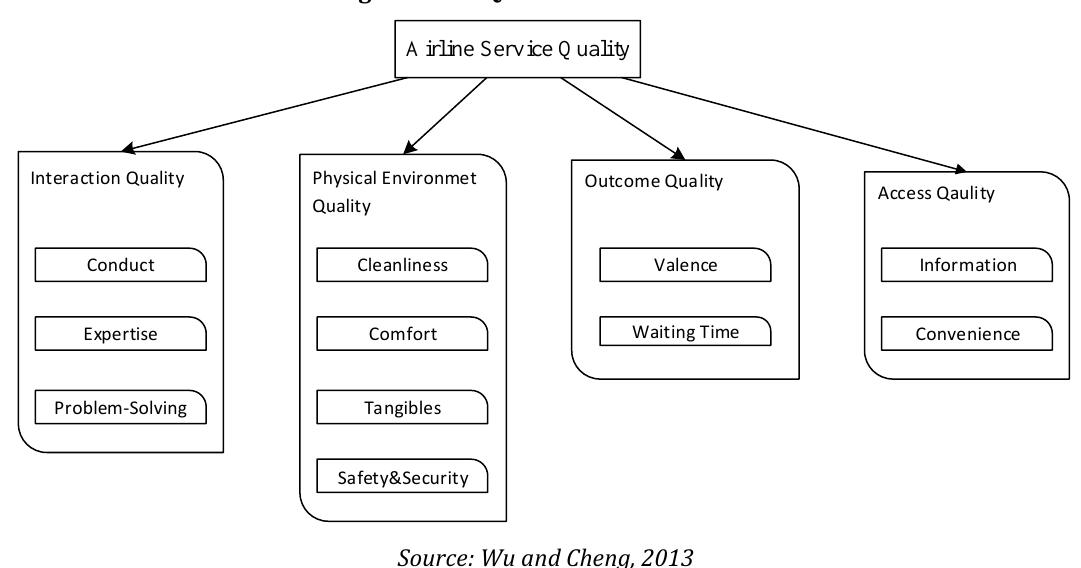
Figure 10: SSQAI measurement scale